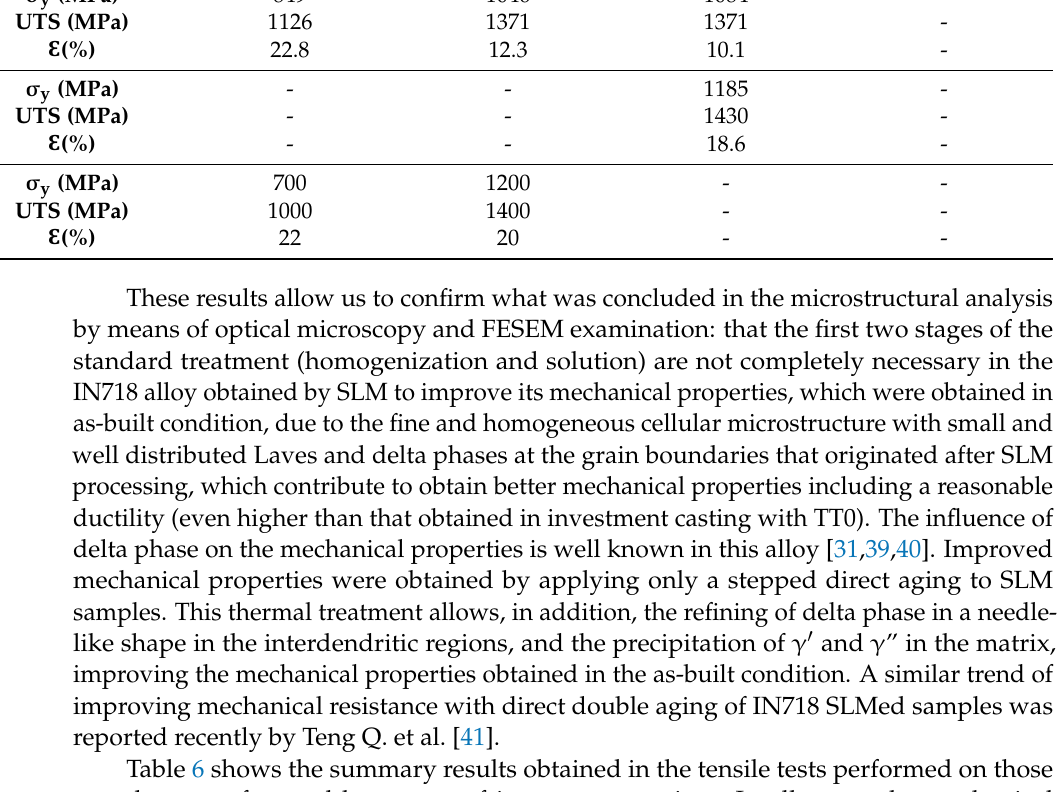
Table 5. Summary of mechanical properties for SLM IN718 alloy in this work compared to other